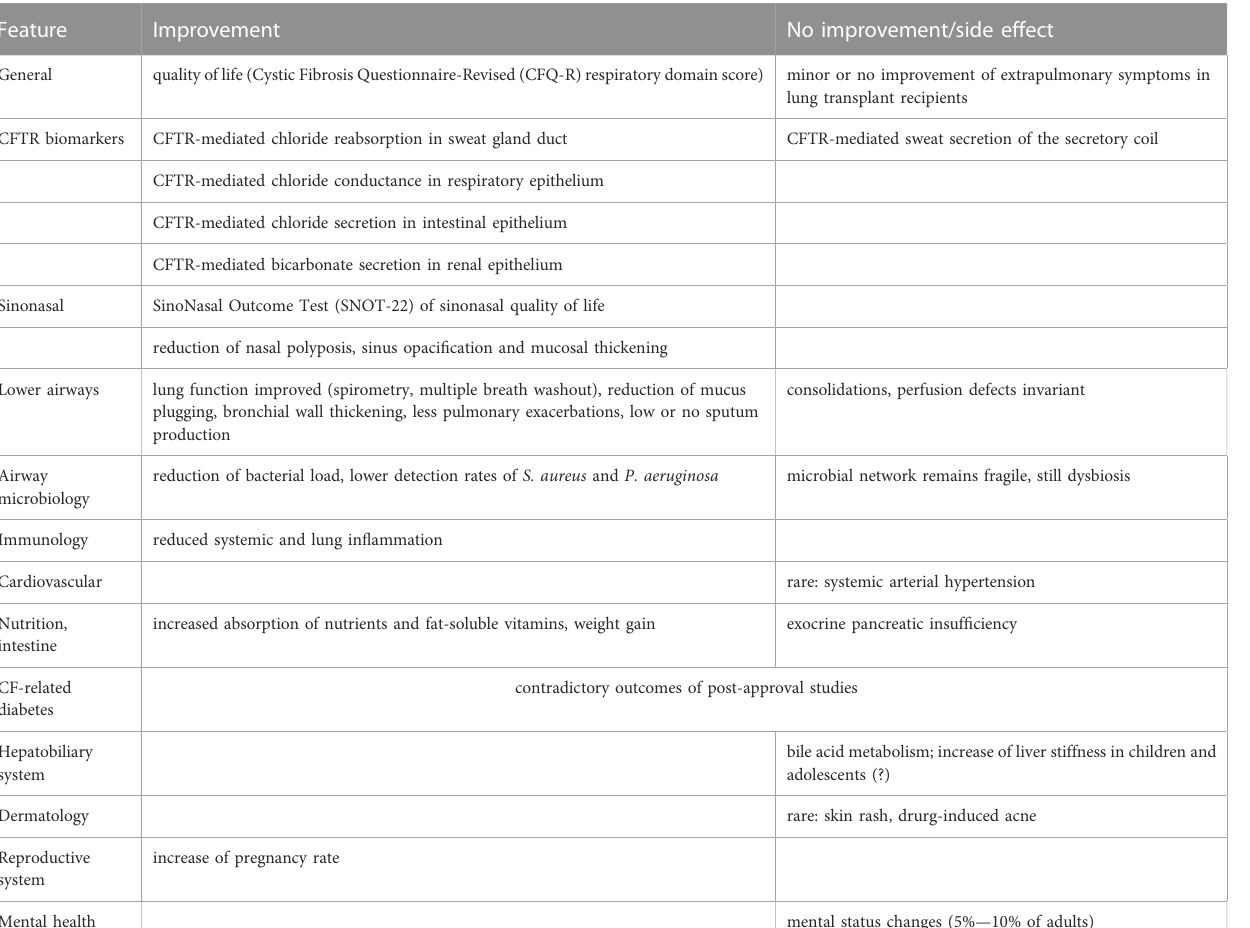
TABLE 4 Real-world response of pwCF to triple therapy with ELX/TEZ/IVA*.